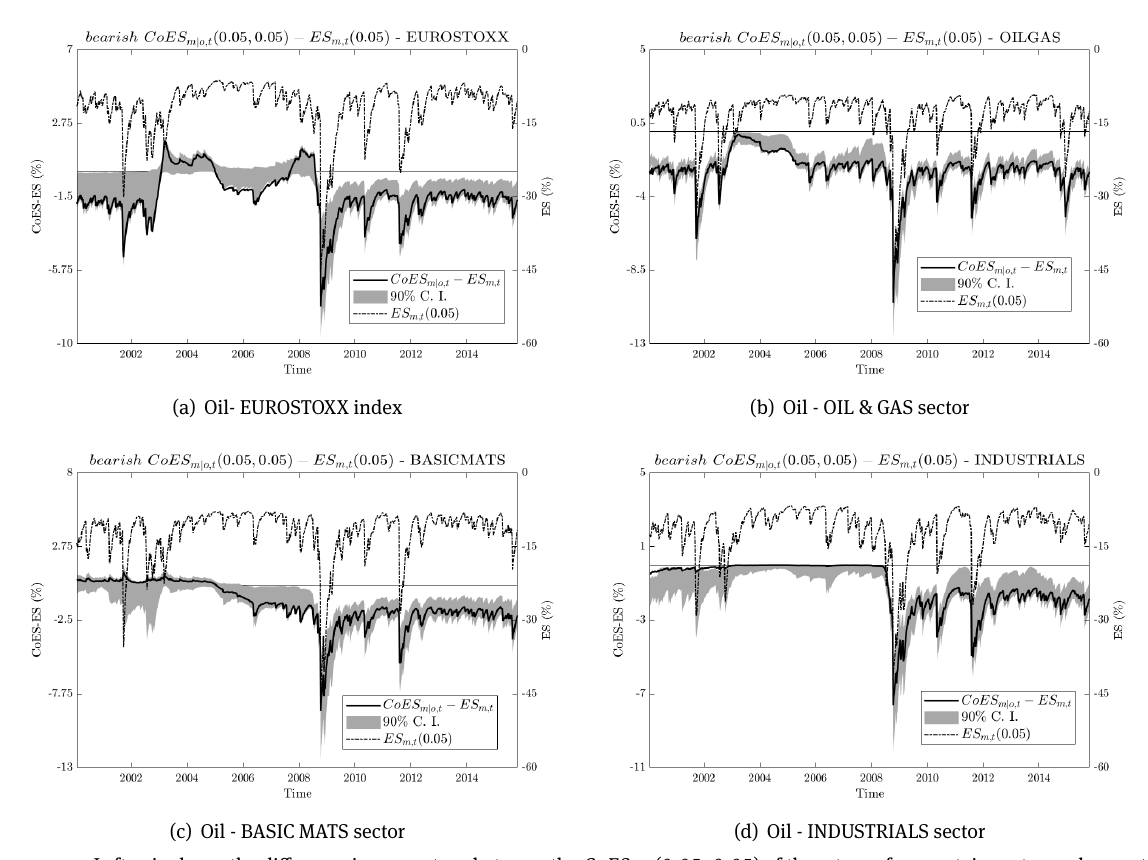
Figure 18a: CoES m | o , t (0.05, 0.05) for a certain sector given a bearish scenario for oil